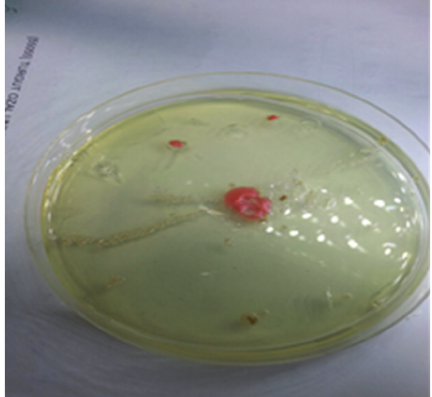
Figure 2: The yeast colonies on SDA at the first cultivation of the nail